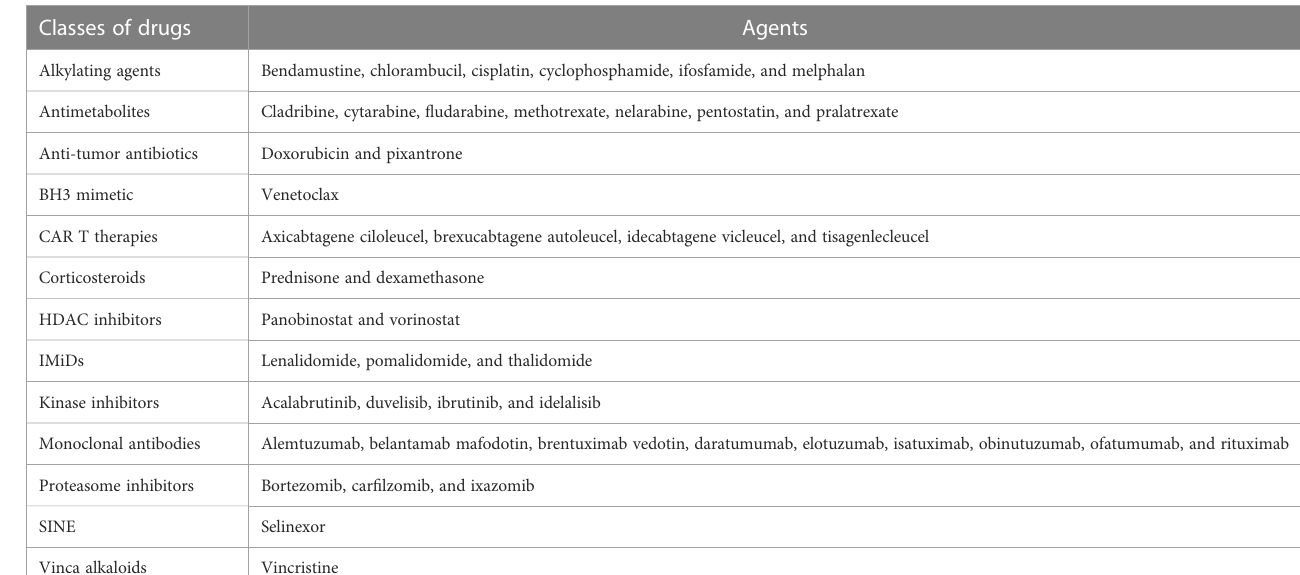
TABLE 2 Selected drugs used for the search criteria in PubMed. Classes of